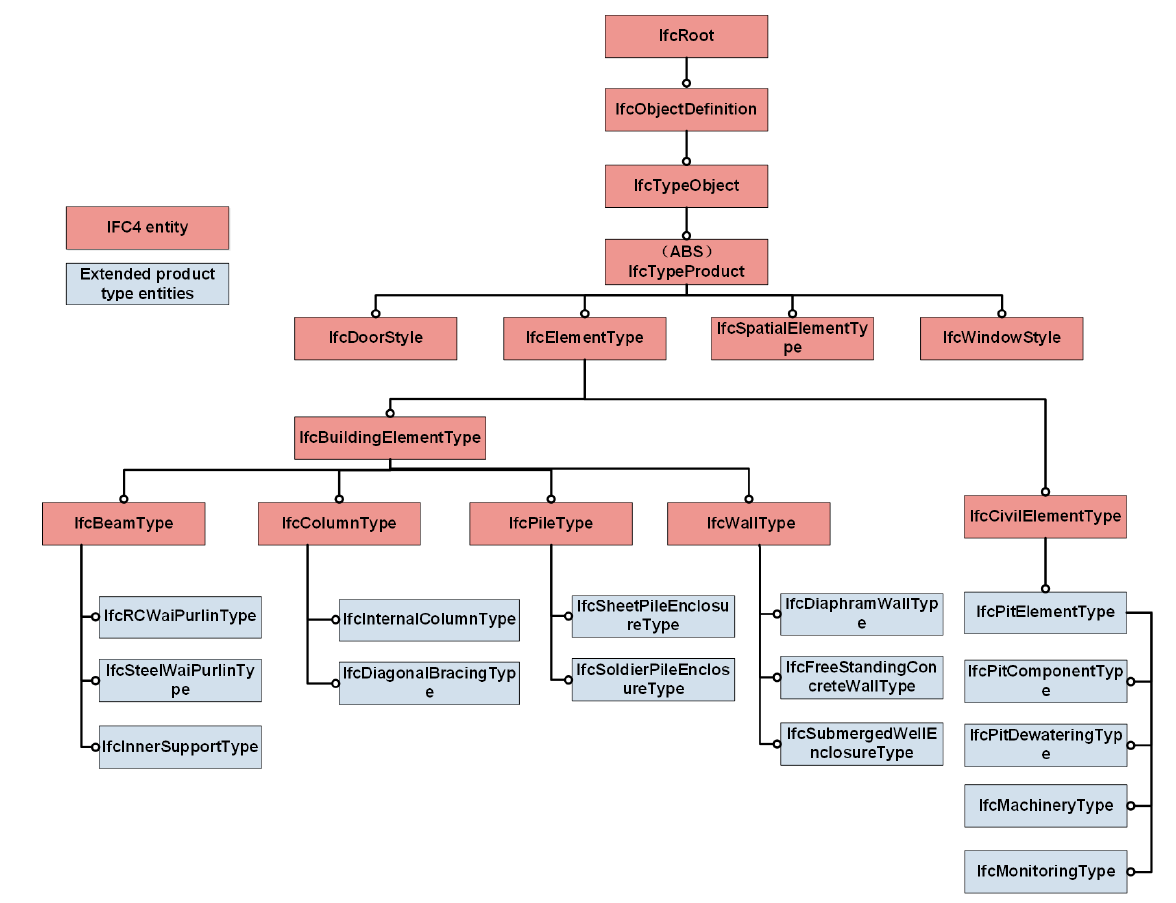
Figure 6. IFC expression with extensions for product type information (I-1-2).